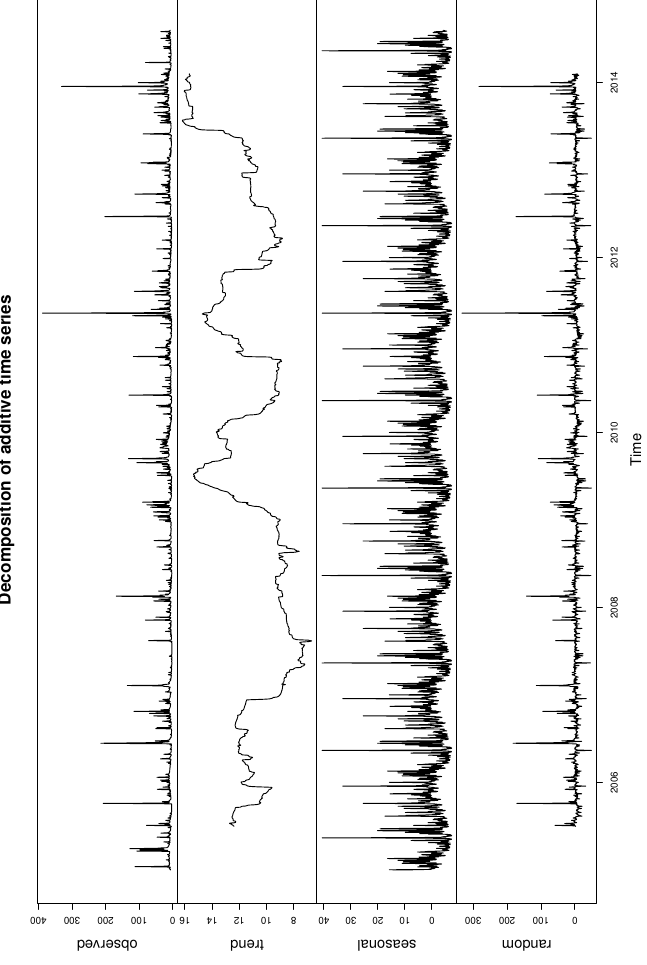
Figure 17. Decomposition of additive time series for Patuxent river daily